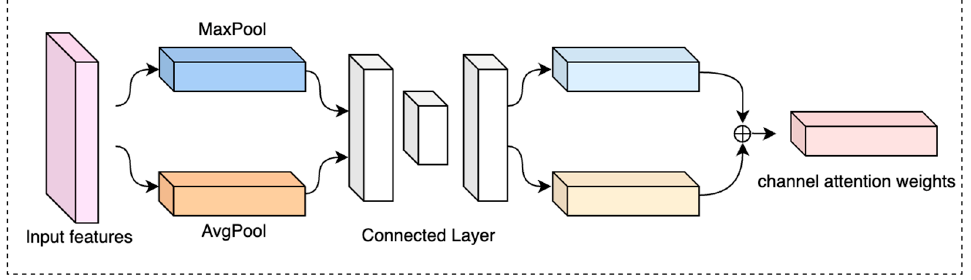
Figure 8. The structure of channel attention.